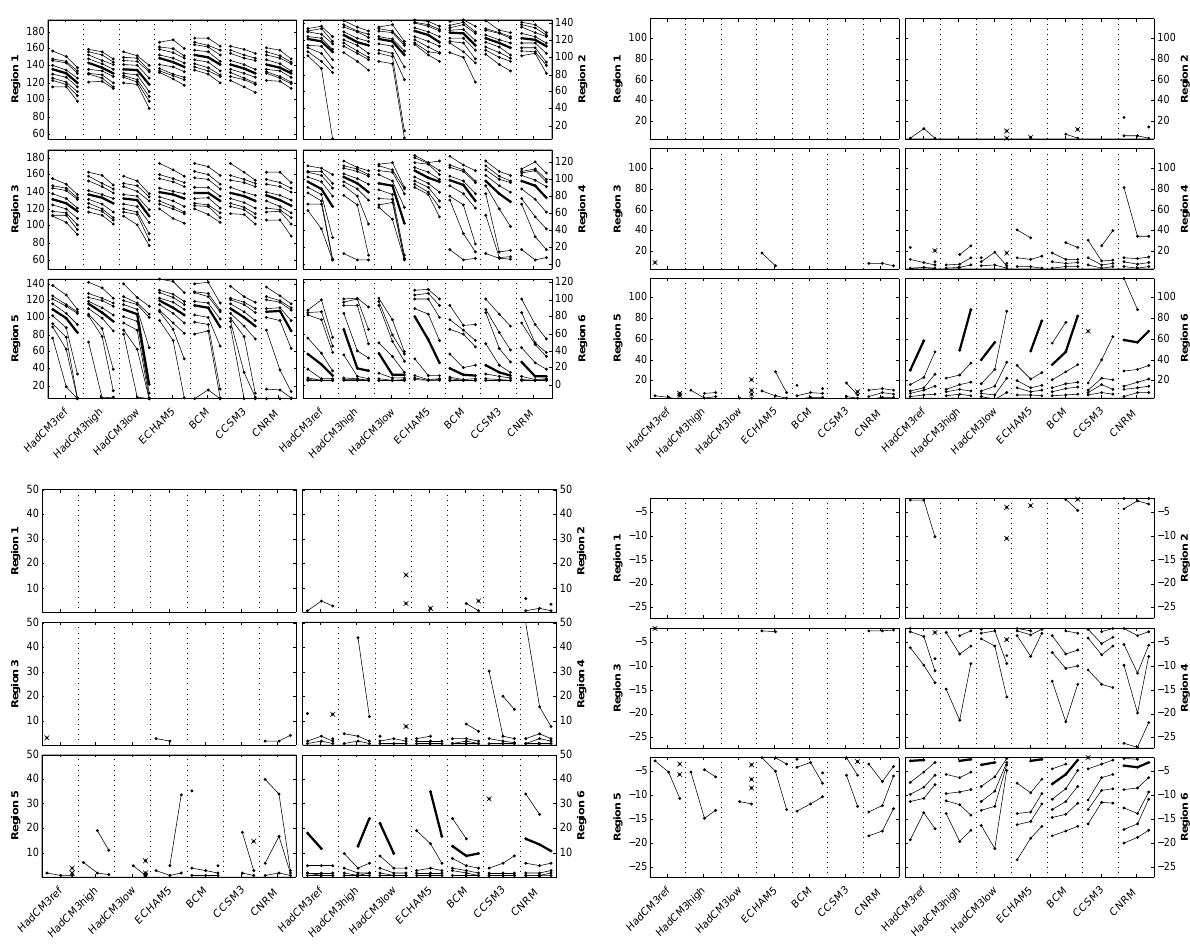
Fig. 11. Climate change profiles of the individual members of the SBI RCA3 GCM ensemble. (a) onset of the vegetation period, (b) the spring backlash index, (c) number of frost events, and (d) the minimum freezing temperature. The left end of each individual profile corresponds to the reference period 1961–1990, and the right end corresponds to the period 2070–2097. The “knee in the middle” corresponds to the intermediate period 2011–2040. Each region in Fig. 1 is shown in a separate panel, having the measure unit as y-axis and the driving GCM indicated in separate sections along the x-axis. Nine percentiles were calculated (1%, 5%, 10%, 25%, 50%, 75%, 90%, 95% and 99%) based on data for all gridcells in the region and all years in the period. If the measure was not given any value in some years, the corresponding percentiles were set to a missing value. If a percentile value could be calculated for one period only, it is shown as a cross. The 50% is highlighted by a thicker